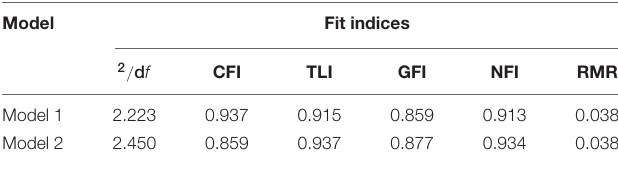
TABLE 5 | Comparison of the models. Model Fit